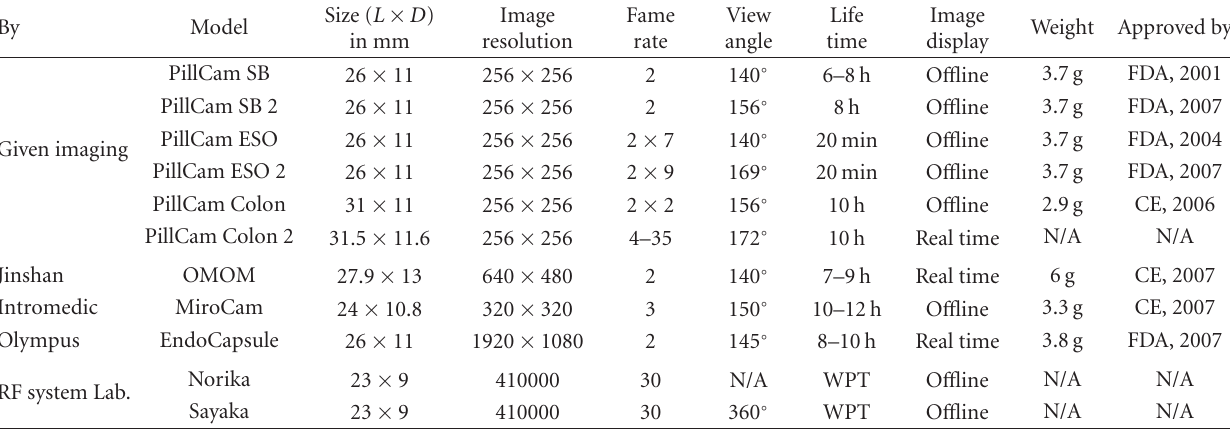
Table 1: Specification of current wireless endoscopic capsules [26, 28, 30–49].